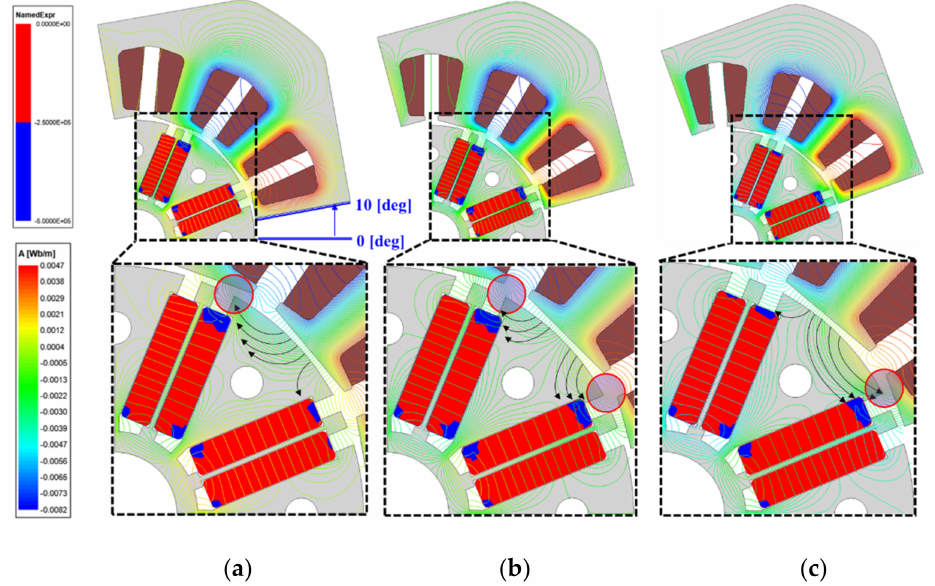
Figure 14. Irreversible demagnetization area of I spoke-type PMSM. ( a ) 10 deg; ( b ) 15 deg; ( c ) 20